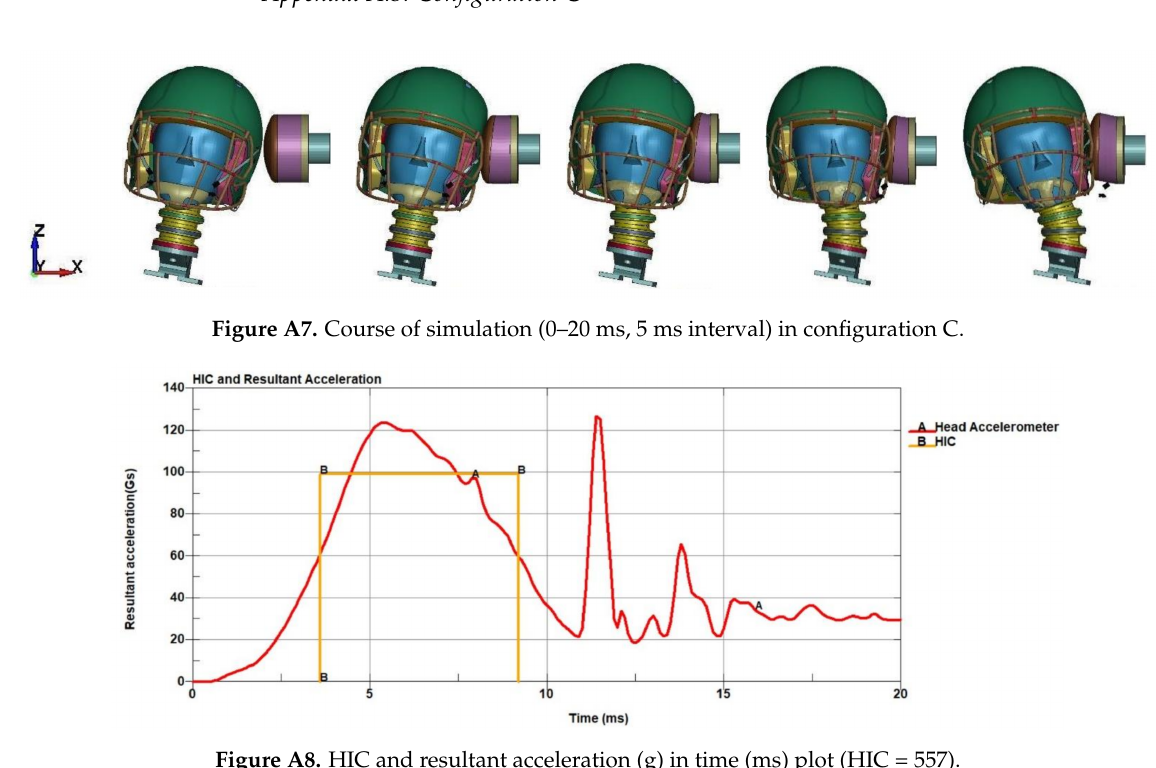
Figure A8. HIC and resultant acceleration (g) in time (ms) plot (HIC = 557). Brain Sci. 2021 , 11 , x FOR PEER REVIEW